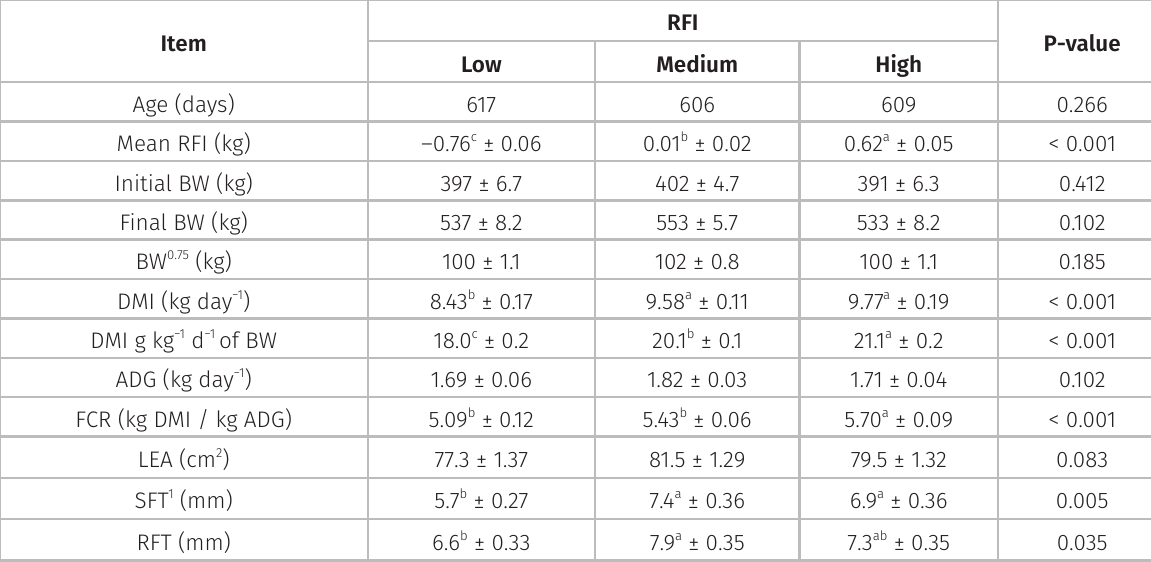
Table II. Growth performance, loin-eye area (LEA), subcutaneous fat thickness (SFT), and rump fat thickness (RFT) of Nellore bulls classified according to residual feed intake